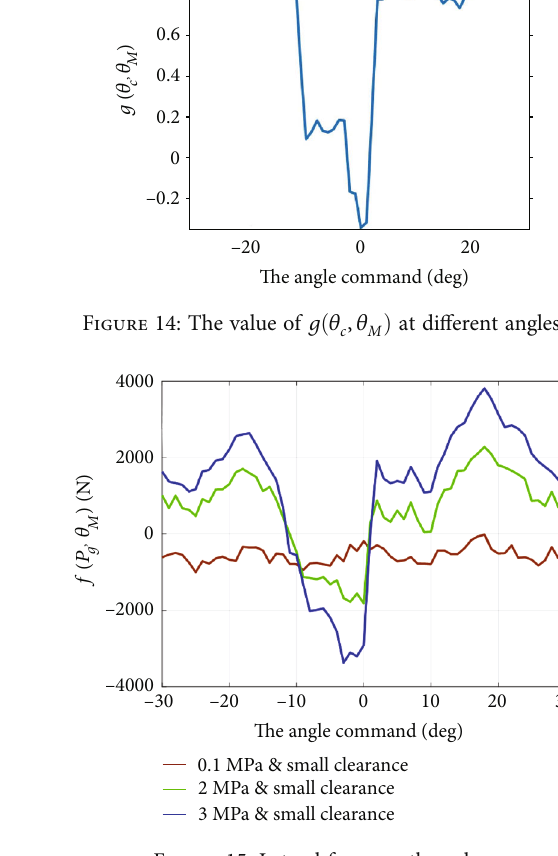
Figure 15: Lateral force on the